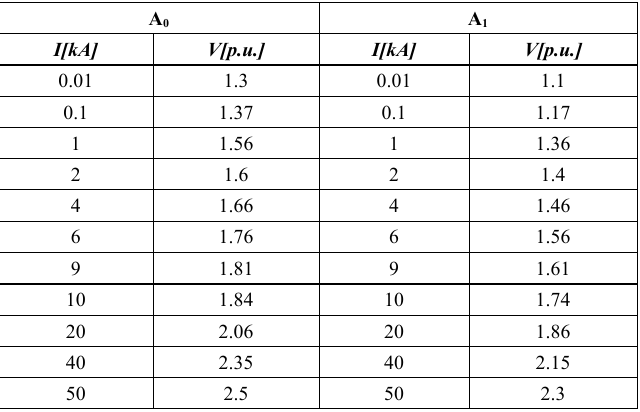
Table 3. V-I characteristics for nonlinear resistances A 0 and A 1